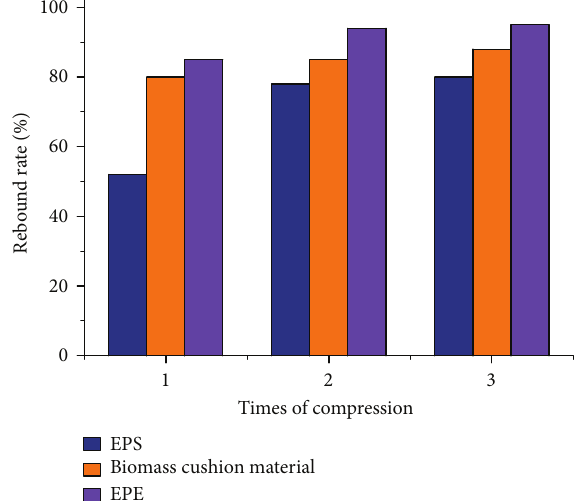
Figure 7: Compression rebound ratio for three